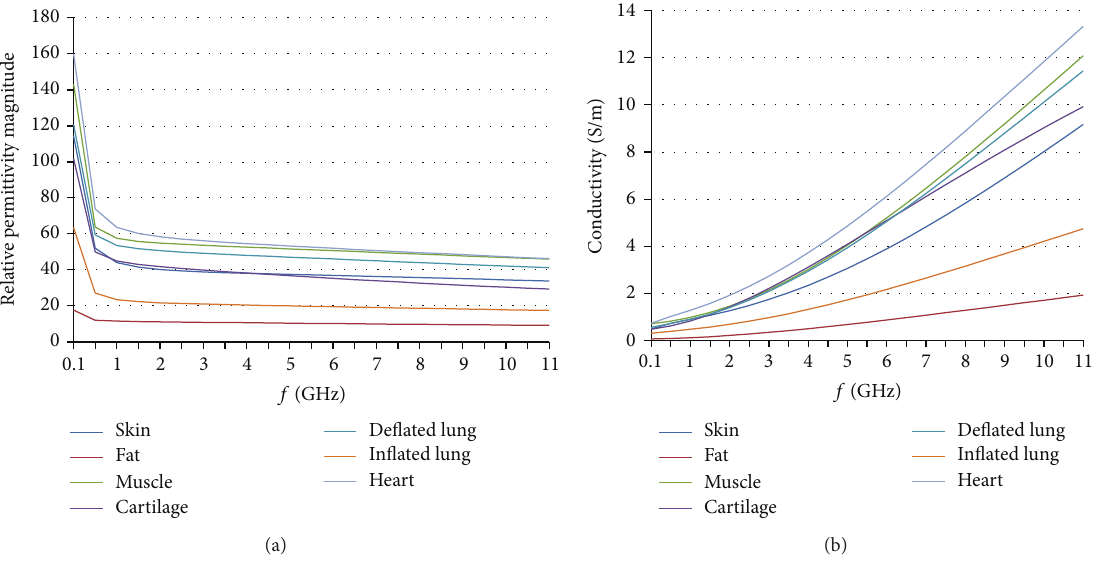
Figure 4: Variation of (a) relative permittivity; (b) conductivity of tissues with